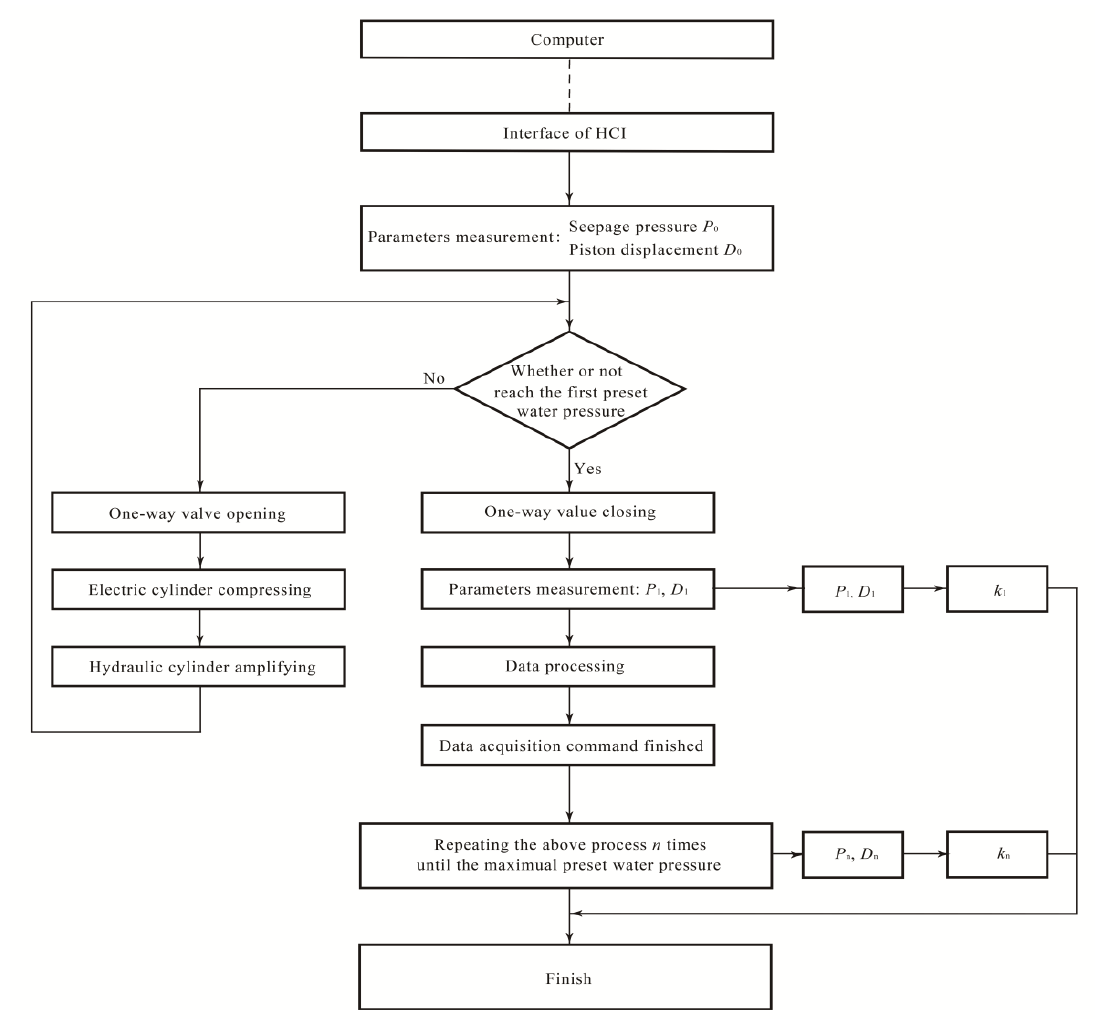
Figure 5. Principles of the simple fully automatic testing method of seepage indices for low-permeability materials. P 1 , D 1 , k 1 , P n , D n , and k n are the seepage pressure, the displacement of the servo motor, and the corresponding calculating values of the permeability coefficient of the specimen under the first-level and the n- level seepage pressures, respectively.